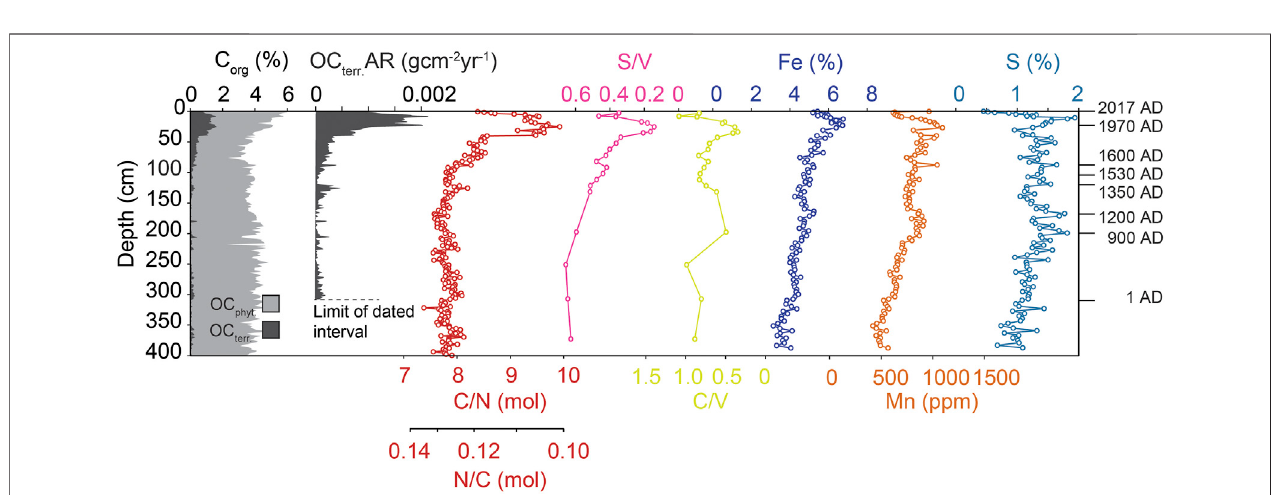
FIGURE 3 | Solid-phase components of the sediments at the Storfjärden site. The fi gure combines data from the GEMAX core of April 2015 (0 – 40 cm) and the pistoncoreofSeptember2017(40 – 400 cm).FractionsofC org derivedfromphytoplankton(OC phyt. )andterrestrialorganicmatter(OC terr. )werecalculatedfromN/Cdata using Eq. 3 and Eq. 4 . Dates on the right-hand margin correspond to tie-points in the Pb tot -based age vs depth model ( Figure 2 ).